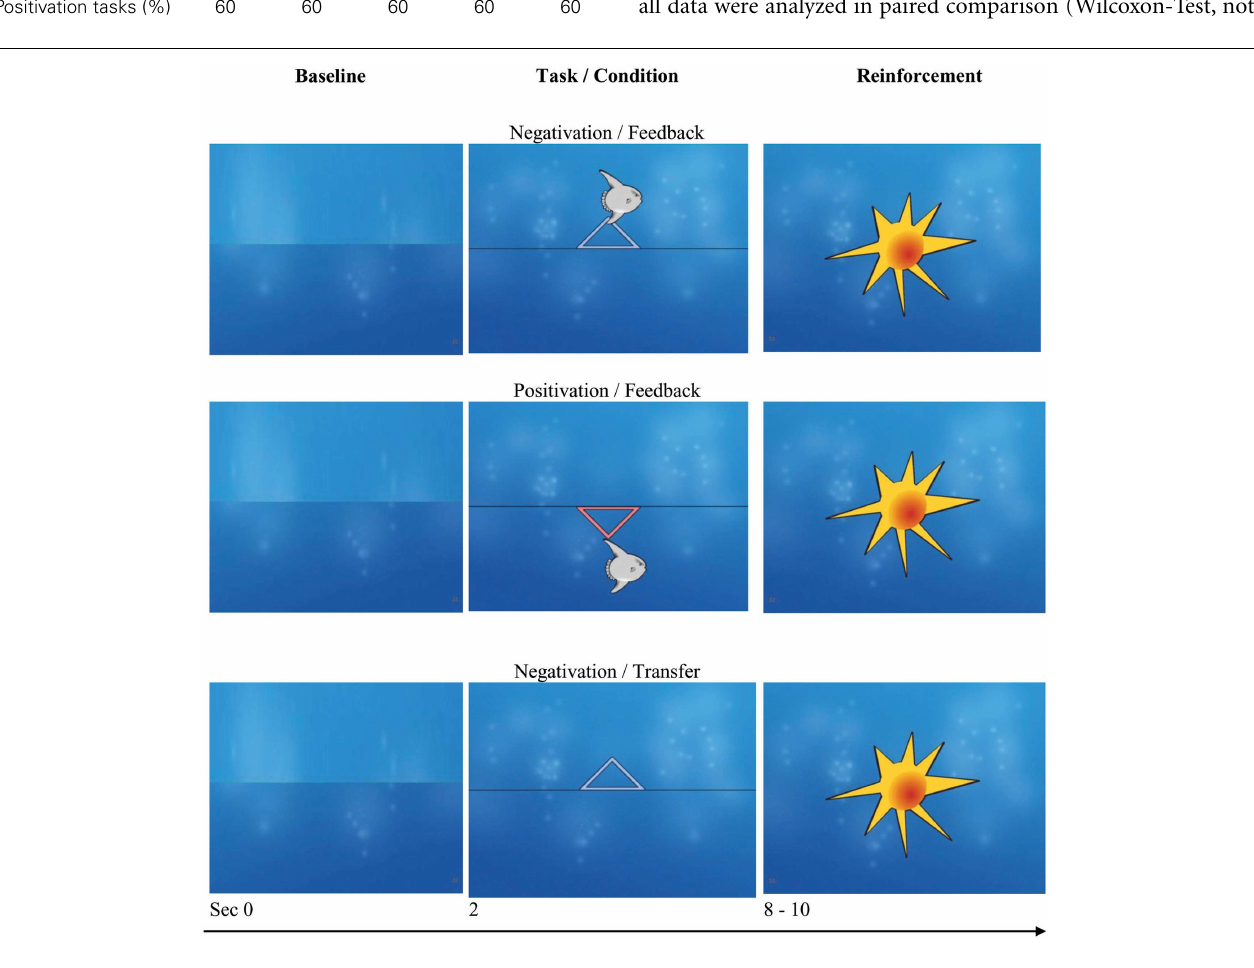
negativation; down, positivation) a “sun” is shown at the end of the trial. In the case of no success, the screen is empty as shown in the bottom line. Screen shots with friendly permission by neuroConn, Ilmenau,